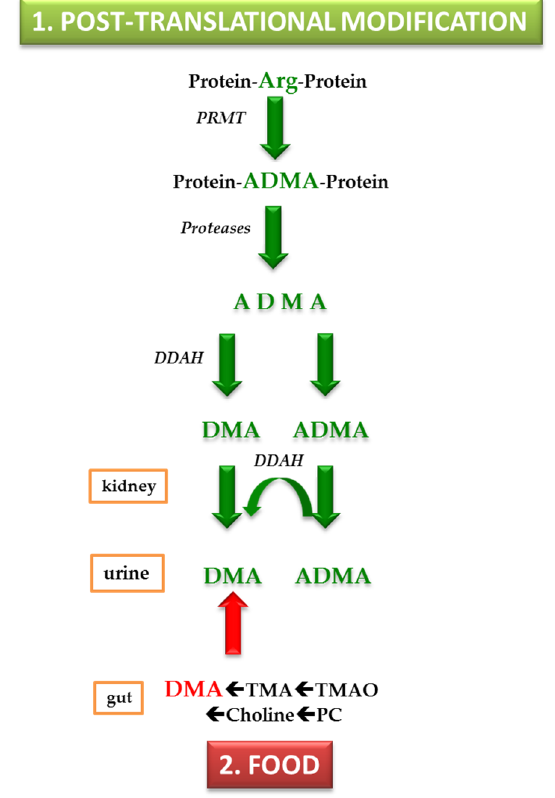
Figure 2. Simplified schematic of two major origins contributing to urinary dimethylamine.